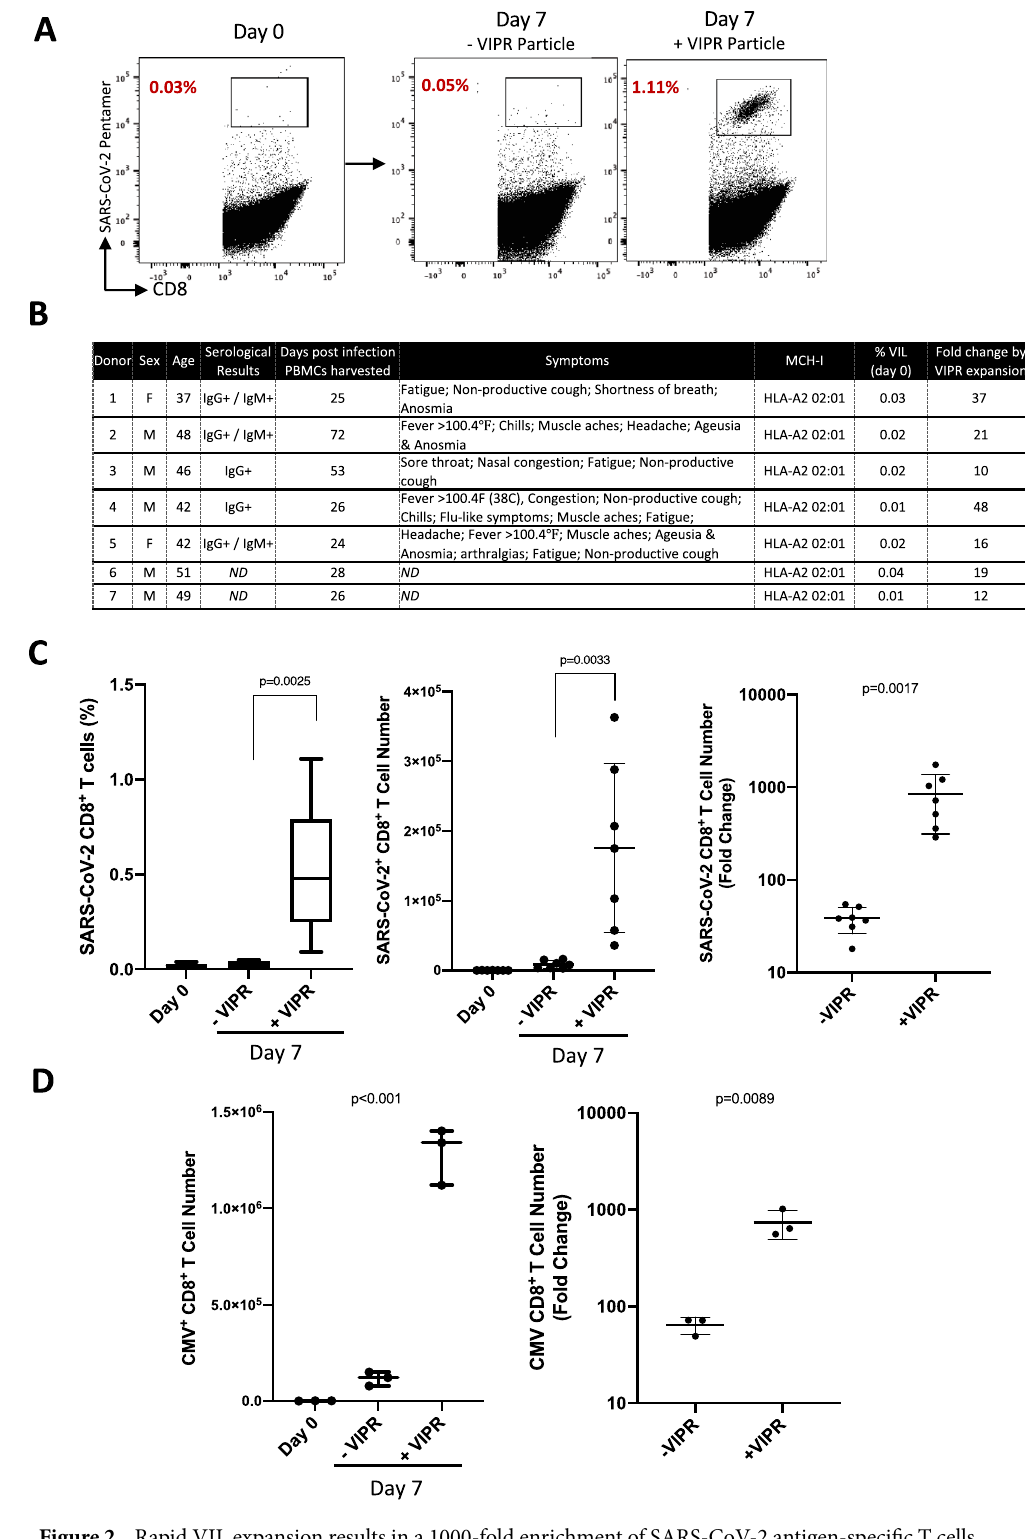
Figure 2. Rapid VIL expansion results in a 1000-fold enrichment of SARS-CoV-2 antigen-specific T cells within 7-days from convalescent donors. ( A ) Representative flow-cytometric analysis showing proportions of SARS-CoV-2 antigen-specific CD8 + T cells 7-days after expansion and enrichment with YLQPRTFLL antigen- specific VIPR Particles. ( B ) Table describing the clinical presentation of convalescent COVID-19 donors used in this study and the proportions of SARS-CoV-2 specific VIL detectible before enrichment, and fold expansion by VIPR particles. ( C ) Summary of CD8 + SARS-CoV-2 VIL %, cell number and fold change after VIPR expansion ( n = 7). ( D ) Histograms showing total CMV pp65 antigen-specific CD8 + T cell numbers expanded by VIPR particles after 7-days and overall fold change in antigen specific cells ( n = 3)